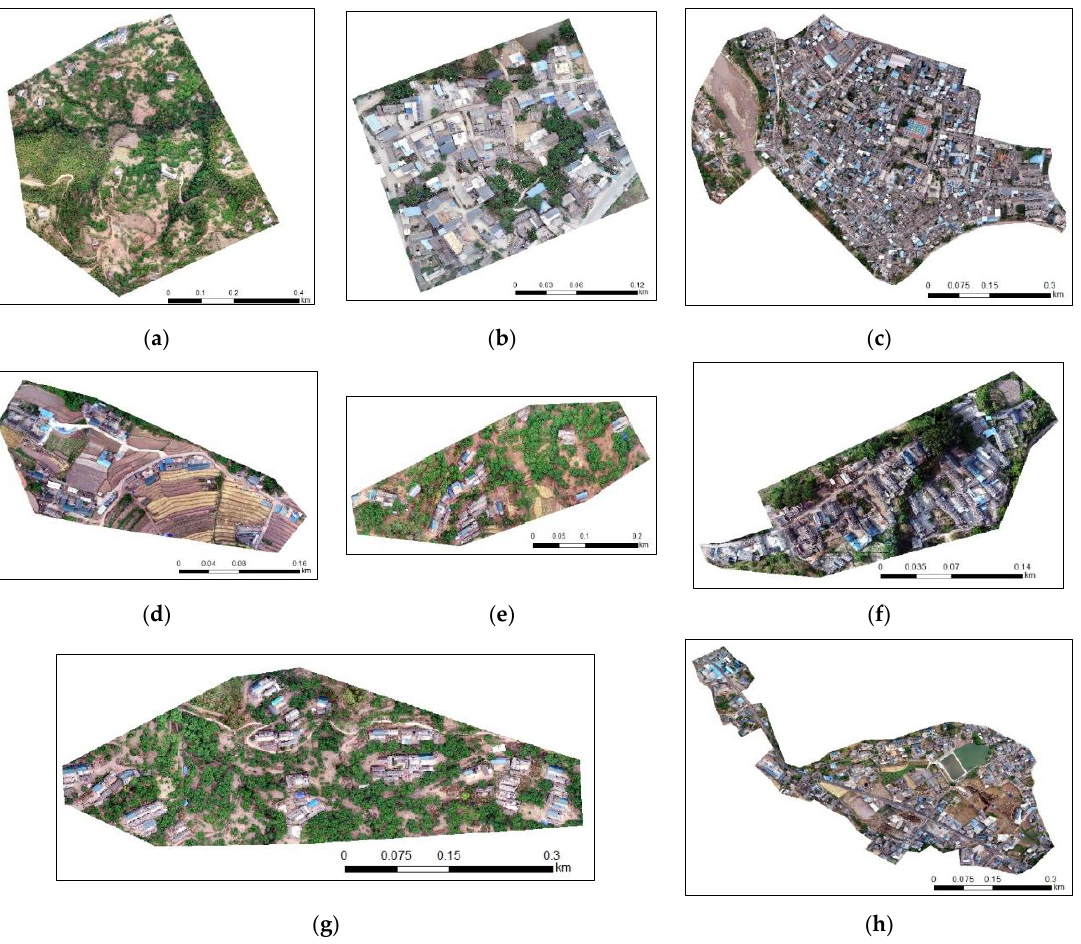
Figure 4. The UAV orthophotos acquired after the Yangbi Earthquake in Cangshanxi Town, Yangbi County, Yunnan Province: ( a ) Beiyinpo; ( b ) Jinniu; ( c ) Xiajie; ( d ) Baiyang ( e ) Cunwei; ( f ) Baimu; ( g ) Hetaoyuan, and ( h ) Longjing.